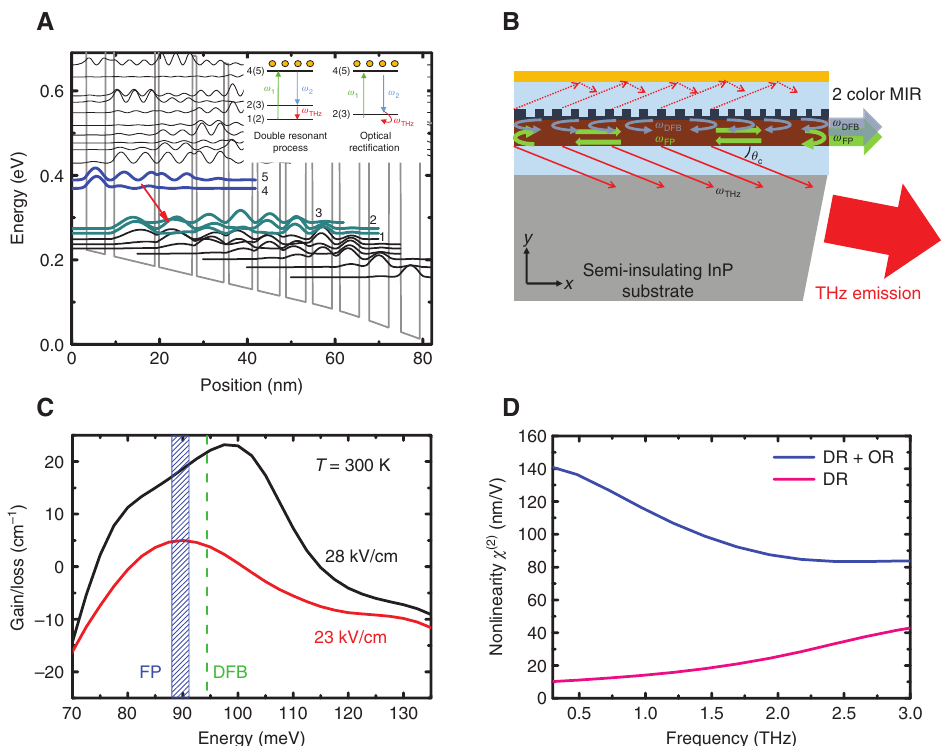
Figure 1: Design of sub-THz QCL source. (A) Schematic conduction band diagram and squared moduli of the relevant wavefunctions of the injector/active/injector parts of the active region. An electric field of 28 kV/cm was applied to align the structure. The lattice-matched In period of the active layers starting from the injection barrier (i.e. toward the right) is given in angstroms as follows: 34 /43/ 20 /93/ 9 /76/ 10 /62/ 11 /54/ 12 /51/ 13 /46/ 15 /45/ 17 /45/ 22 /45/ 27 /44, where the InAlAs barrier layers are in bold, the InGaAs quantum well layers are in Roman type, and the doped layers (Si, 1.7 × 10 17 cm −3 ) are underlined. The schematics of the non-linear DFG processes for the double resonant process and for optical rectification are also shown in the inset. (B) Schematic of a distributed feedback/Fabry-Pérot configuration for non-linear THz-QCL. (C) Gain/absorption amplitude characteristics of the DAU active region design, calculated using the NEGF quantum transport code, along with the spectral positions of a single MIR pump frequency selected using a distributed feedback grating and the Fabry-Pérot modes of the second MIR pump as selected via the laser cavity. (D) Calculated optical non-linearity χ (2) for the active